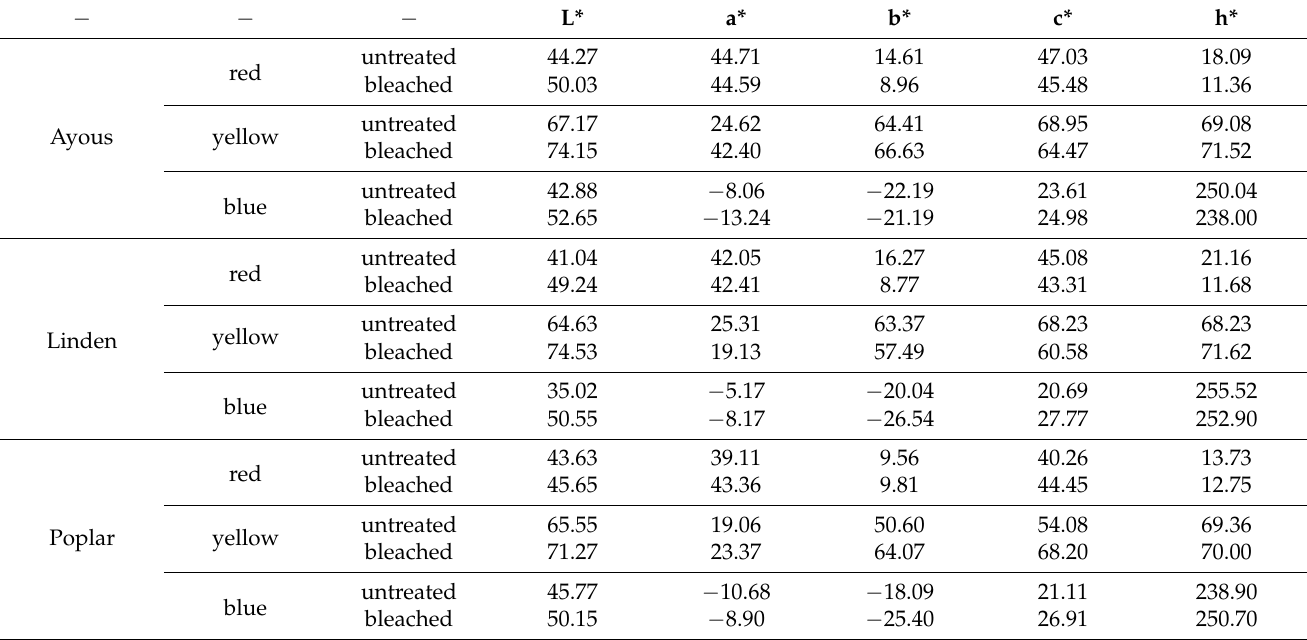
Table 3. Color depth values of the dyed